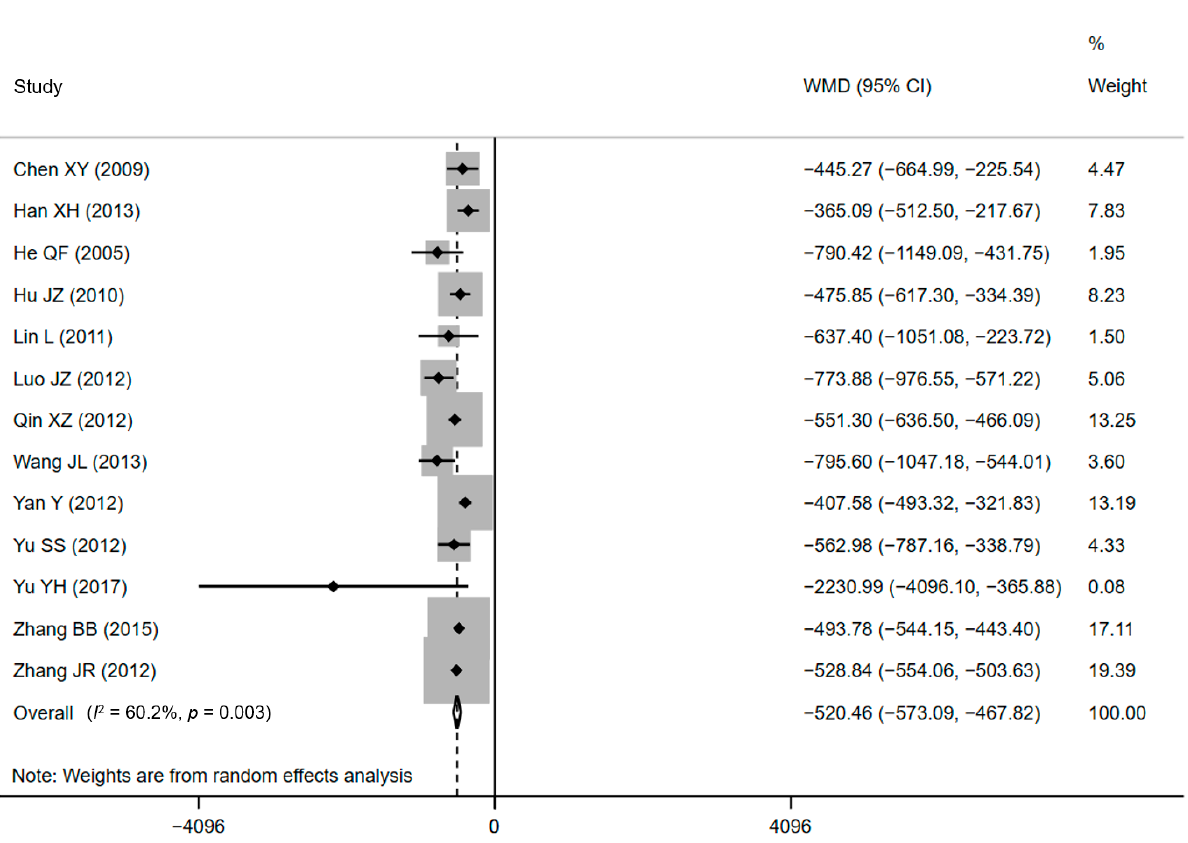
Figure 3. Forest plot of effects on DHC. Abbreviations: WMD, weighted mean difference; CI, confidential interval; DHC, direct hospitalization cost.